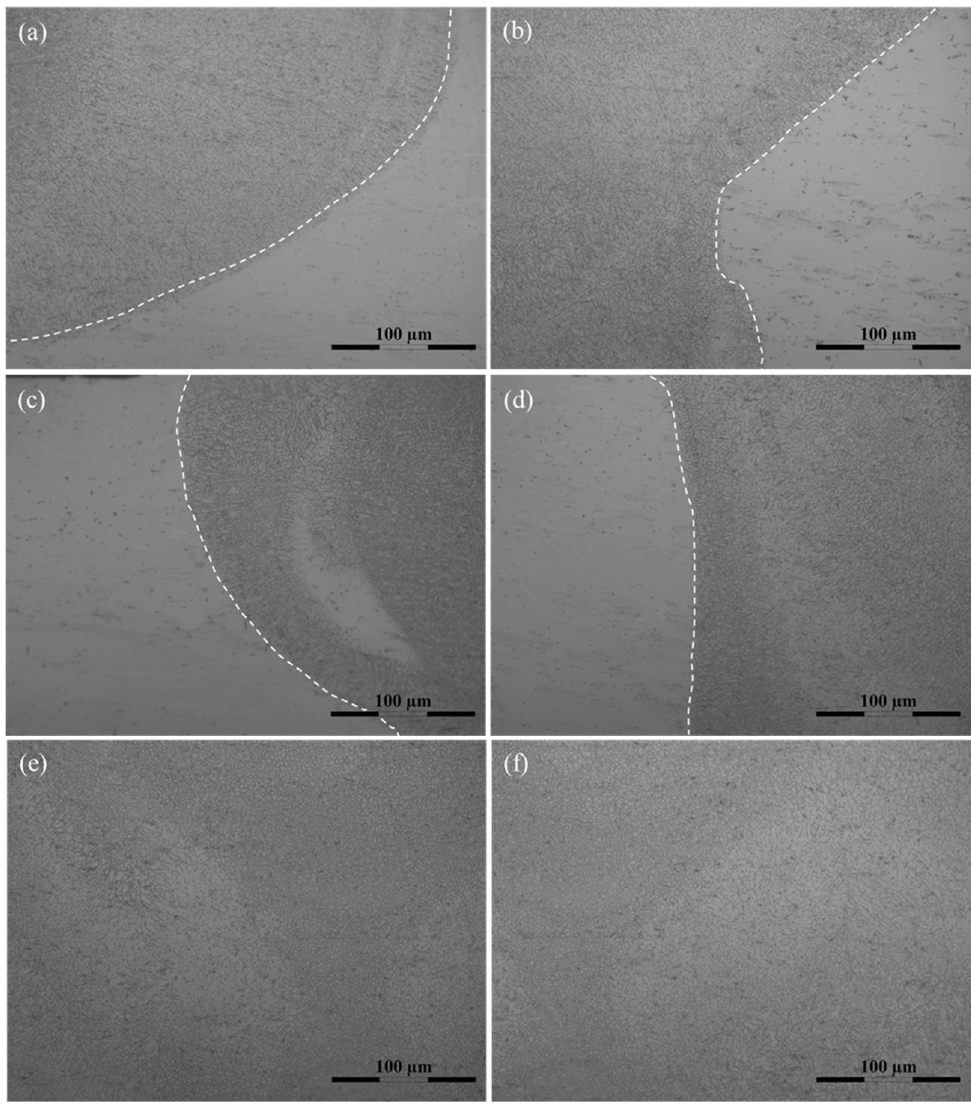
Figure 4. Microstructures of different zones on Figure 3 (No. 3 sample): ( a ) A zone; ( b ) B zone; ( c ) C zone; ( d ) D zone; ( e ) E zone; ( f ) F zone. (The white dotted line indicates the fusion zone boundary). SEM images of the interfaces between the Nb and both the NiTi and the Ti 2 AlNb base materials are shown in Figure 5a. The red circle was the starting point for the line scan. As shown in Figure 5b,c, the Nb interlayer formed defect-free interfaces with the NiTi sheet, while there was a small gap between Ti 2 AlNb and the Nb interlayer at a particular dis- tance from the centre of the weld, which might aid in fracture propagation upon mechan- ical testing.